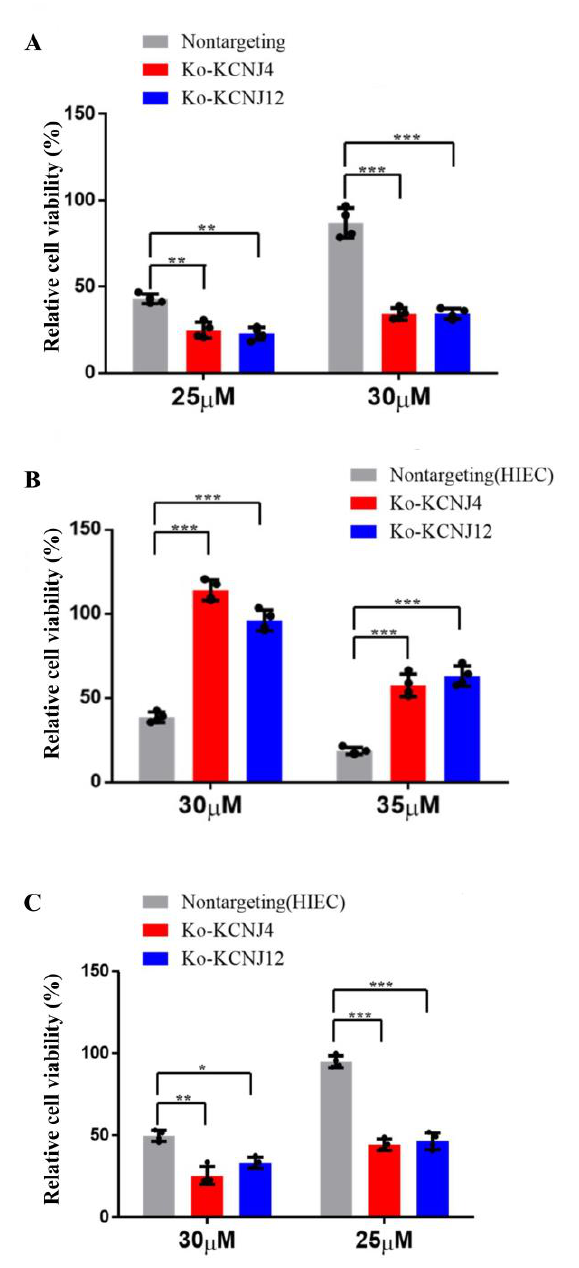
FIGURE 2: Overexpression and knockout of KCNJ4 and KCNJ12 regulates ZEA toxin resistance. (A) Knockout of KCNJ4 and KCNJ12 and the percentage cellular viability of cell lines after treatment with either 20 or 25 µM of ZEA. (B) Overexpression of KCNJ4 and KCNJ12 in another cell line (HIEC) and the percentage cellular via- bility after treatment with either 30 or 35 µM of ZEA. (C) Knockout of KCNJ4 and KCNJ12 in another cell line (HIEC) and the percentage cellular viability after treatment with either 30 or 35 µM of ZEA. Data are presented as the mean ± SEM (n=4). p < 0.05 (*), p < 0.01 (**) and p < 0.001 (***), calculated by Student